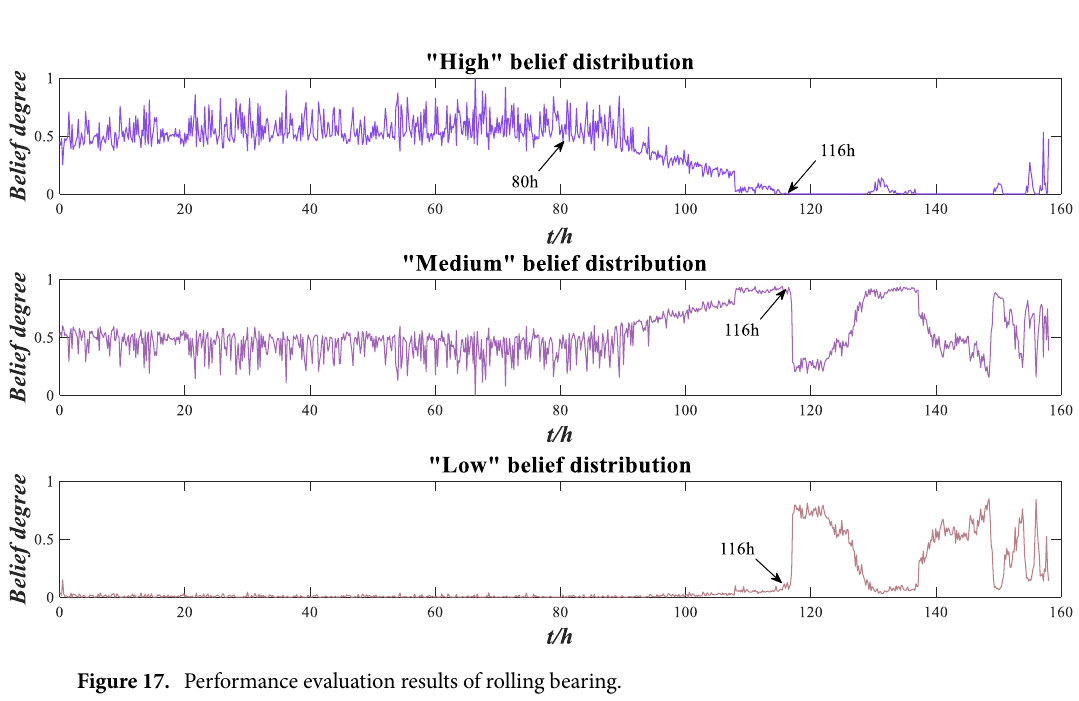
Figure 17. Performance evaluation results of rolling